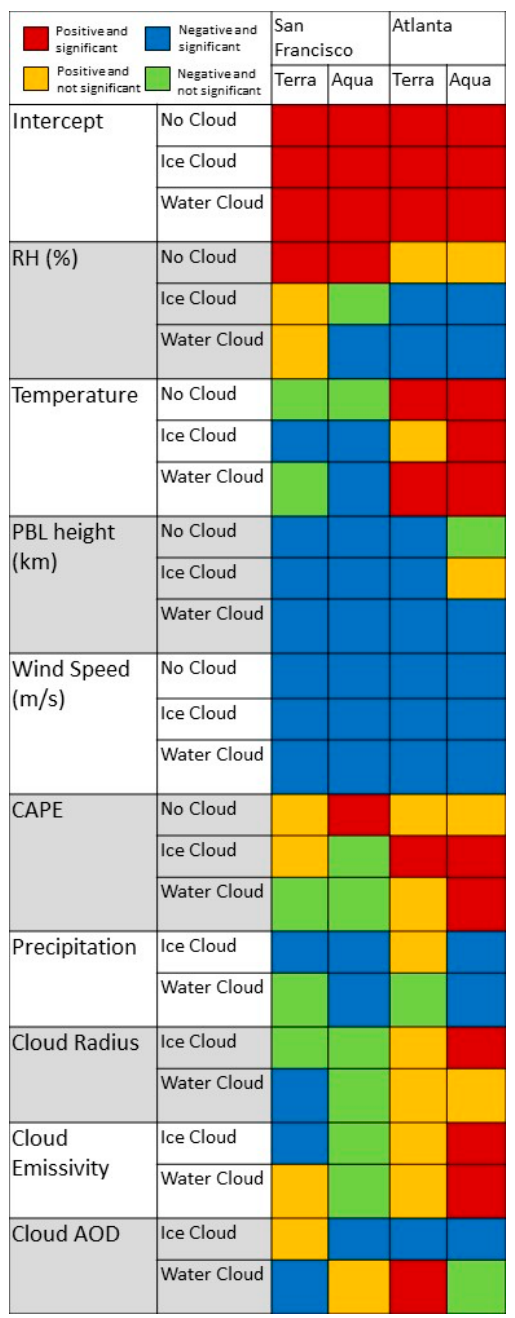
Figure 2. Effect estimate directions and significance for no cloud, ice cloud, and water cloud models. Each estimate is colored according to its direction (positive or negative) and significance (0.05 level). Excepting the intercepts, a positive estimate means an increase in that variable is associated with an increase in PM 2 . 5 concentrations, a negative estimate with a decrease in concentrations.